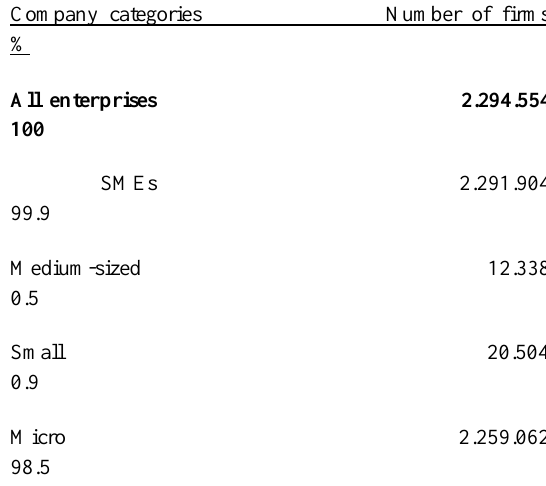
Table 1: SME categorization in Turkey Company categories